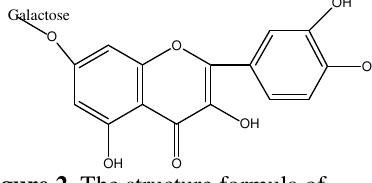
Figure 1. The structure formula of flavone